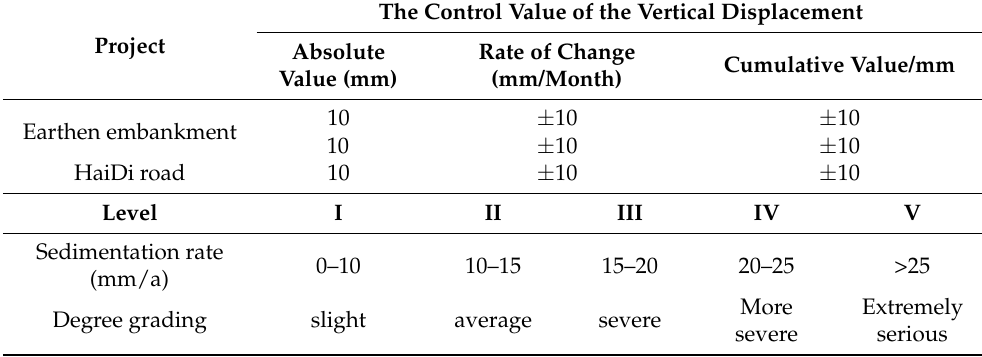
Table 1. Settlement monitoring control values and Ground settlement rate grading standard.